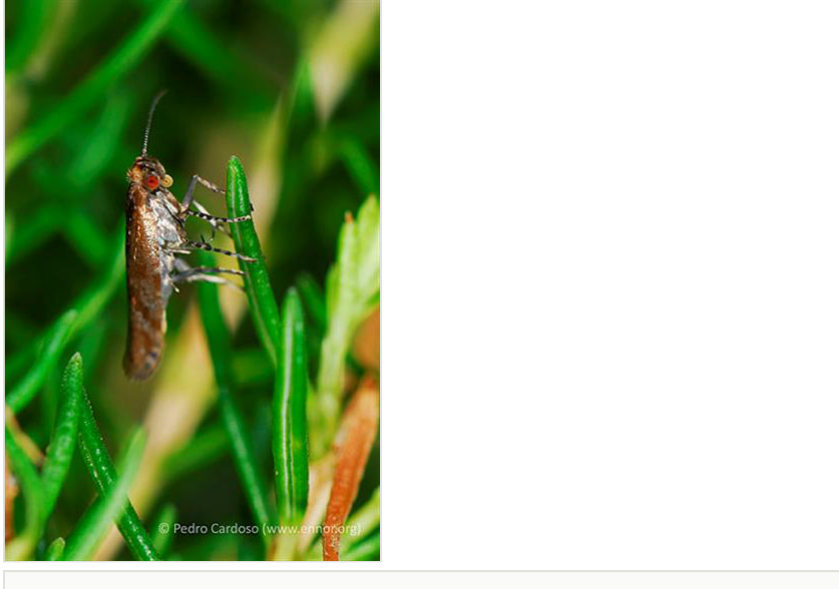
Figure 8. The moth Argyresthia atlanticella (Credit: Paulo A.V.